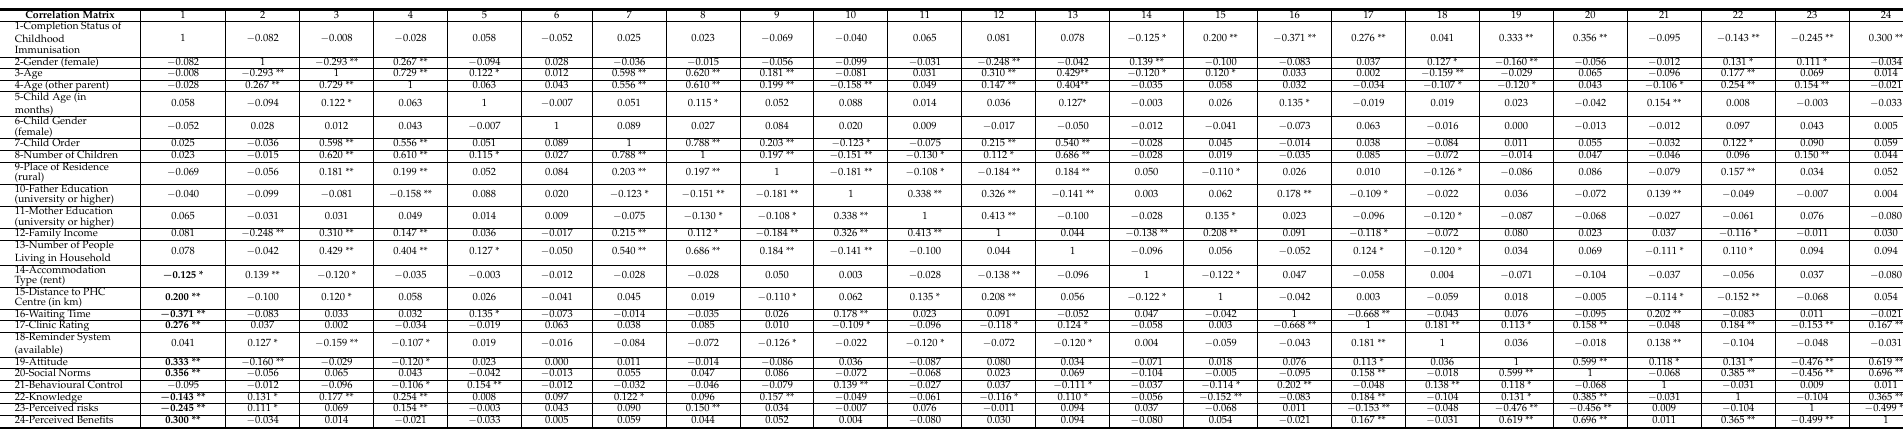
Table 5. Correlation